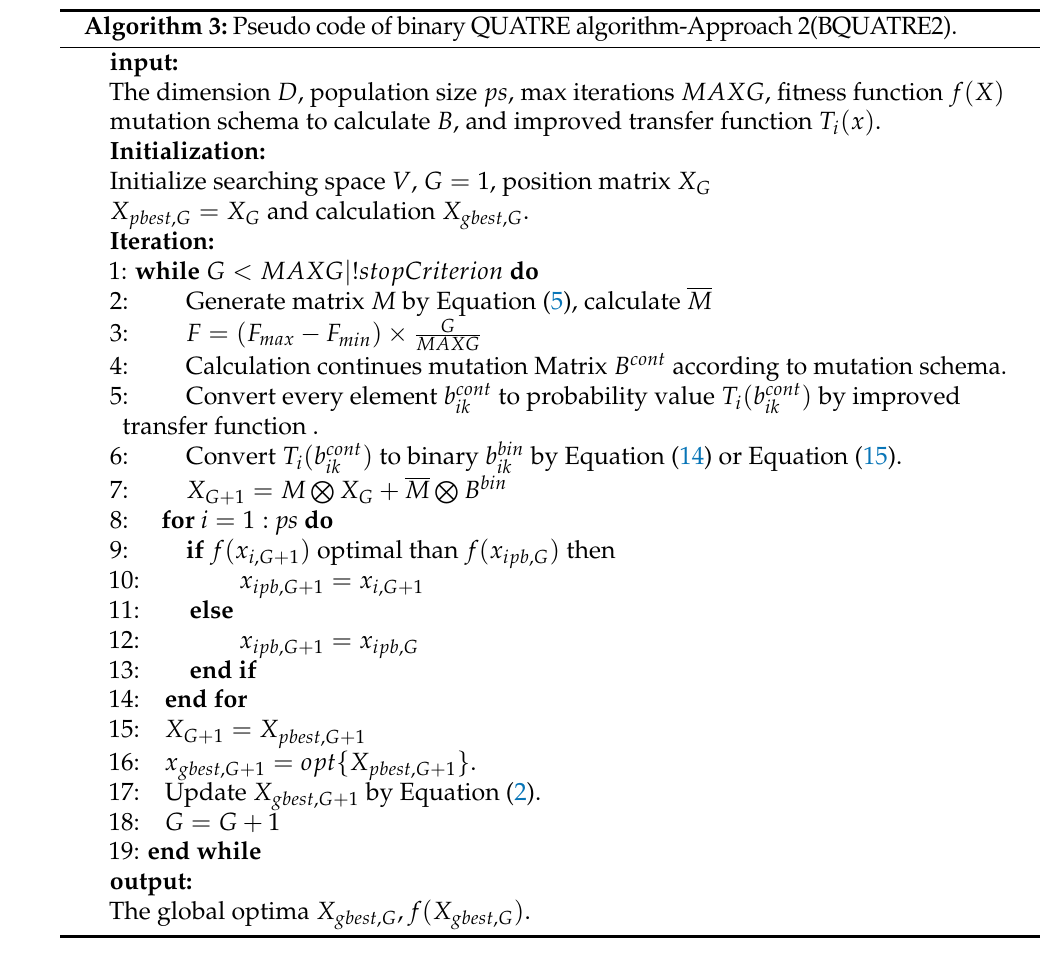
Algorithm 3: Pseudo code of binary QUATRE algorithm-Approach